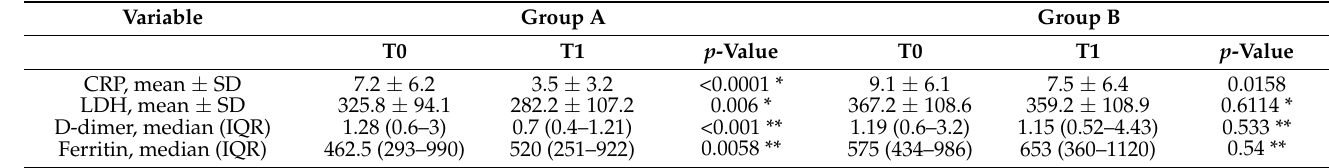
Table 2. Comparison between inflammatory markers at baseline (T0) and after one week (T1) among patients included in our study.